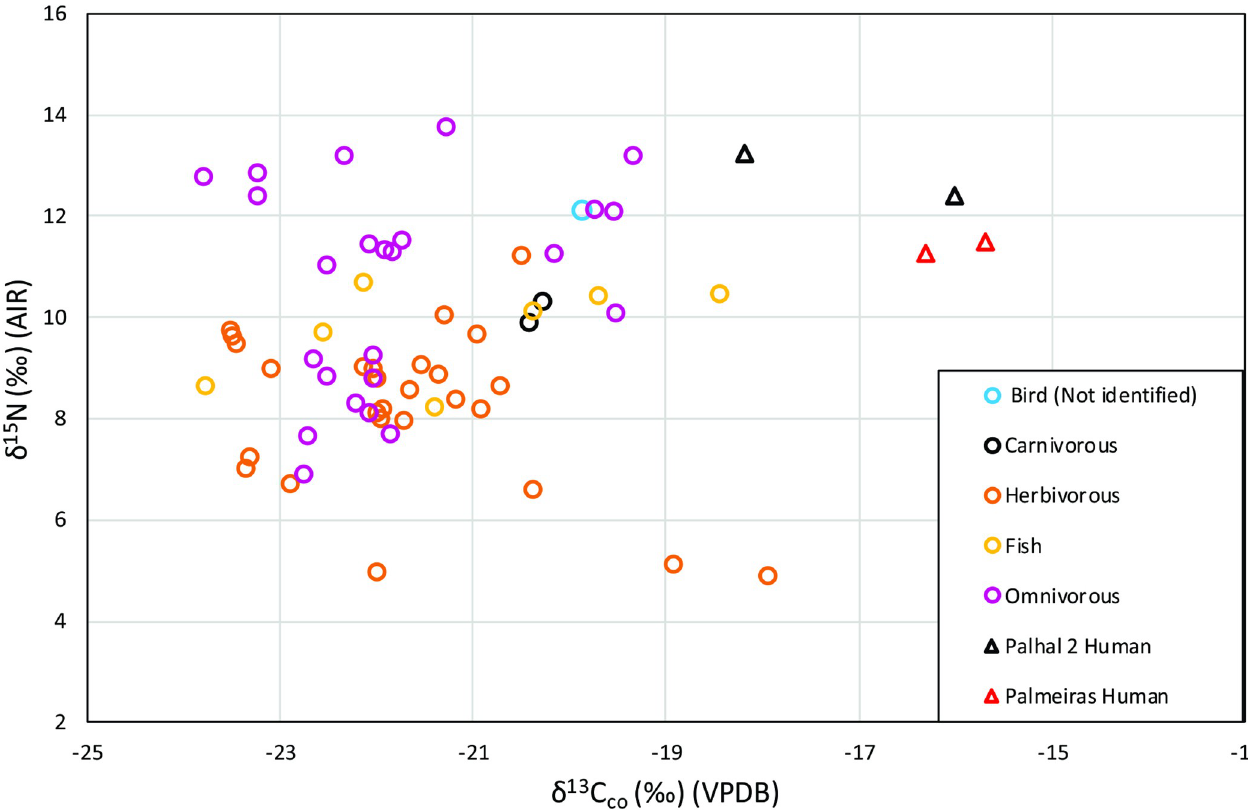
Fig 4. Fauna and human bulk bone collagen δ 13 C and δ 15 N results grouped by diet for VGRX.